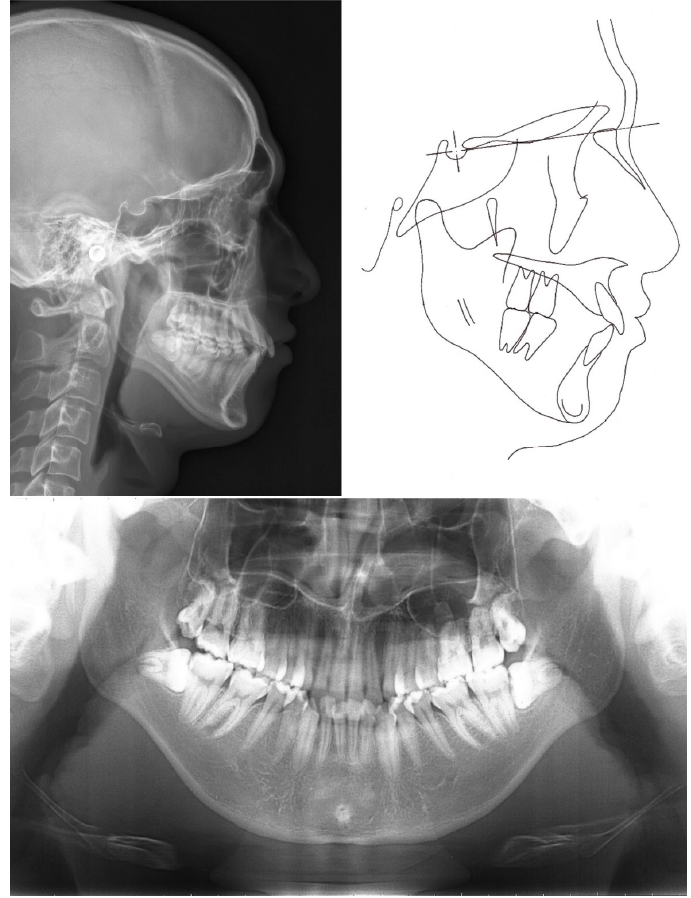
Appl. Sci. 2022 , 12 , x FOR PEER REVIEW Figure 3. Pretreatment lateral cephalometric, cephalometric tracing, and panoramic radiographs.